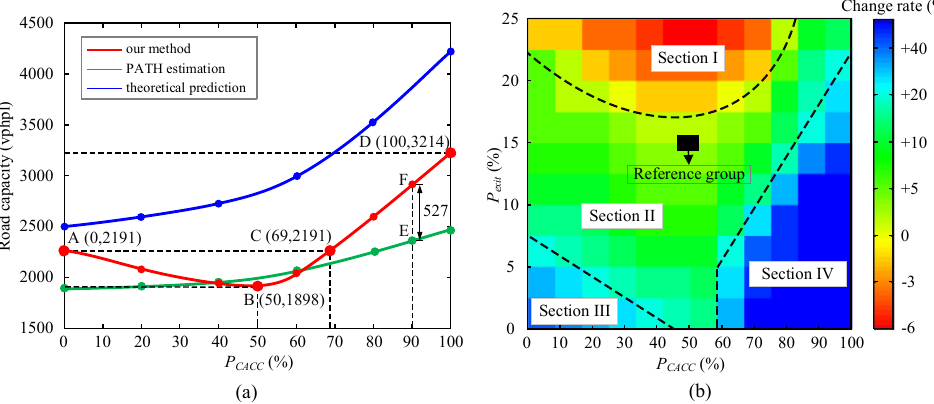
Figure 11. Road capacities in different traffic scenarios. ( a ) denotes capacity changes over P CACC , and ( b ) denotes capacity change rates over P CACC and P exit .